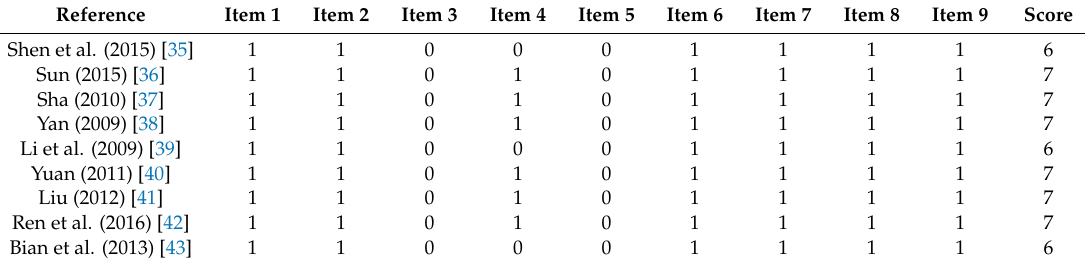
Table 2. Study quality assessment for eligible randomized controlled trials.